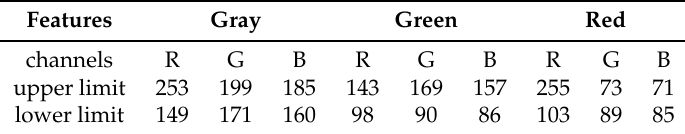
Table 2. RGB segmentation thresholds for feature construction [22].